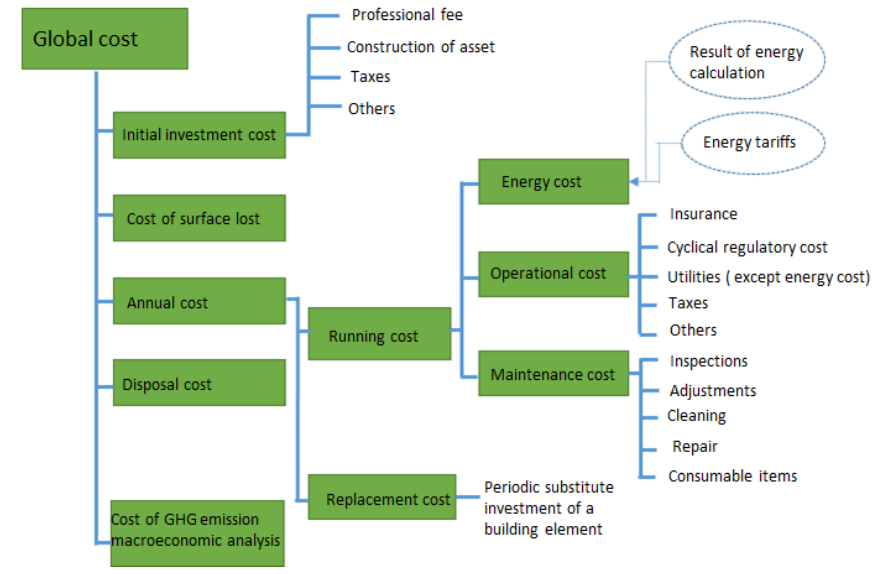
Figure 3. Cost categorization according to the methodology framework (modified from [27]).